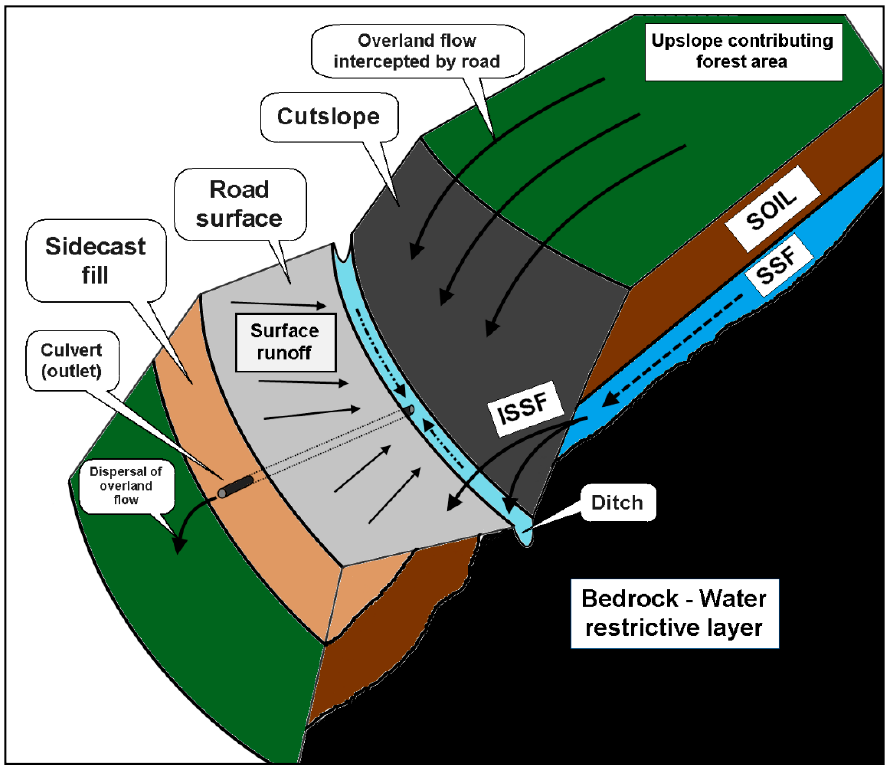
Figure 1. Schematic representation of forest road cutslope, depicting the overland flow, subsurface flow (SSF) and intercepted subsurface flow (ISSF).